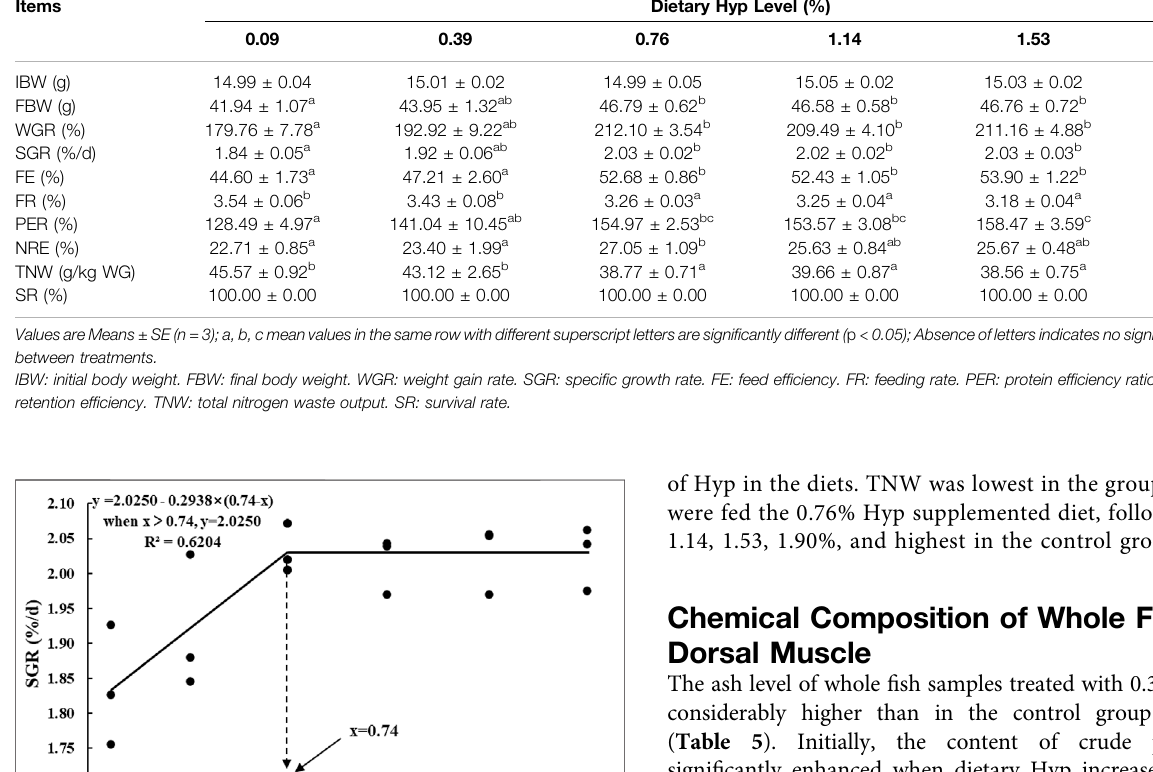
TABLE 4 | Growth, feed utilization and survival rate of ITCC fed with the experimental diets containing different levels of Hyp for 8 weeks. Items